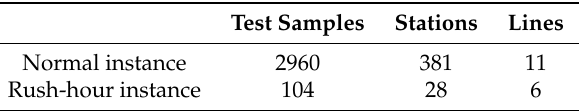
Table 4. Summary of the two test instances generated by 4 test devices: The first instance covers normal train routines used for the temporal, spatial, and pattern matching validation. The second instance covers rush-hour traces, used for estimating speed validation. The term “test samples” below refers to the route between two consecutive stations in the normal instance and to the stopping landmark references in the rush-hour